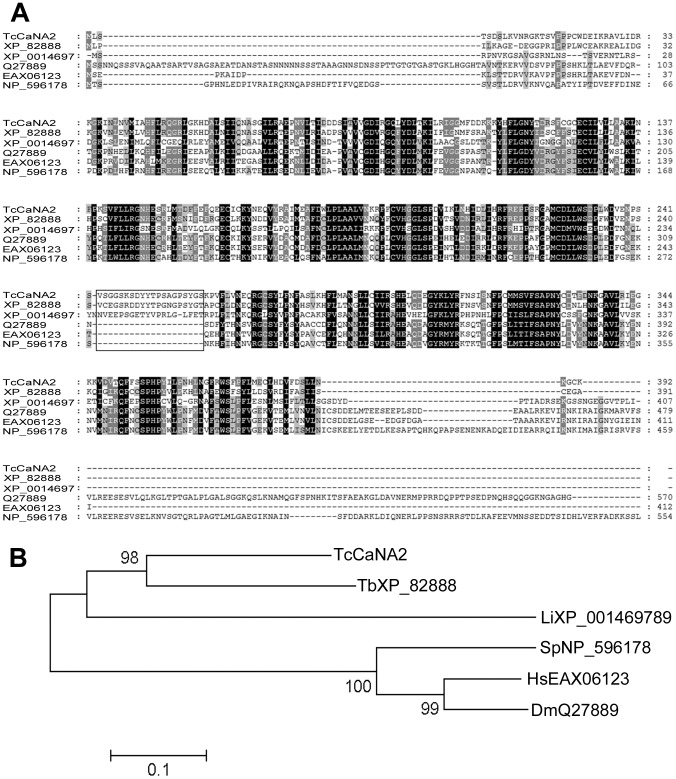
Comparison of TcCaNA2 amino acid sequence with catalytic subunits from different species.A) Alignment of T. cruzi CL strain TcCaNA2 (HM854297) with CaNA from Trypanosoma brucei TREU927 (TbXP_822888.1), Leishmania infantum (LiXP_001469789.1), Schizosaccharomyces pombe 972 h (SpNP_596178.1), Drosophila melanogaster (DmQ27889.2) and the alpha isoform of Homo sapiens (HsEAX06123.1). Genbank accession numbers are in parentheses. Conserved residues are in black (100% conservation), dark gray (>75% conservation) and light gray (>50% conservation); no shading denotes residues with <50% conservation. The peptide sequence 243-VSGGSGSDYYTPSAGPSYGS-262 is marked with a line within the box. B) Phylogenetic tree inferred from the amino acid alignments of TcCaNA2-CL with other CaNAs. Phylogenetic analysis was performed with MEGA4 software [71]. Evolutionary history was analyzed using the Neighbor-Joining method [72] with 1000 bootstrap replicates [73]. Evolutionary distances were calculated using the Poisson correction method [74] and are in units of number of amino acid substitutions.